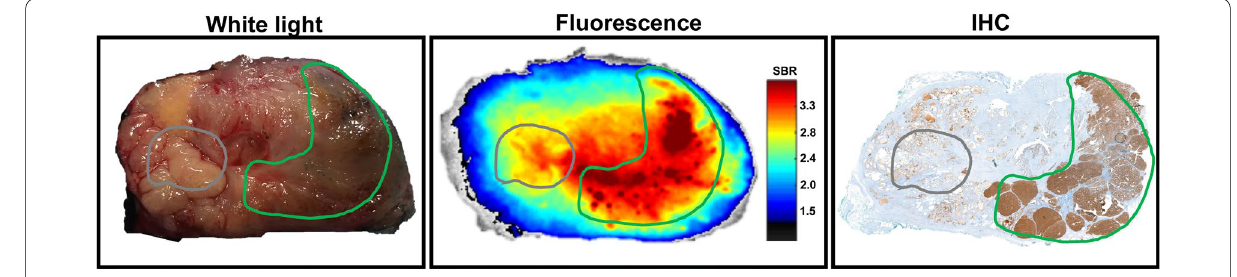
Fig. 3 Ex vivo PSMA-mediated imaging prostate cancer in human prostate samples. A White light image of prostate tissue obtained after prostatectomy of a prostate cancer patient. B Color-coded processing further highlighted the fluorescence uptake. Differences in tracer uptake throughout the tissue after ex vivo tissue incubation with EuK ‐ (SO 3 )Cy5 ‐ mas 3 were further highlighted through the representation of signal-to-background ratio (SBR). C Corresponding PSMA-related immunohistochemistry of the prostate